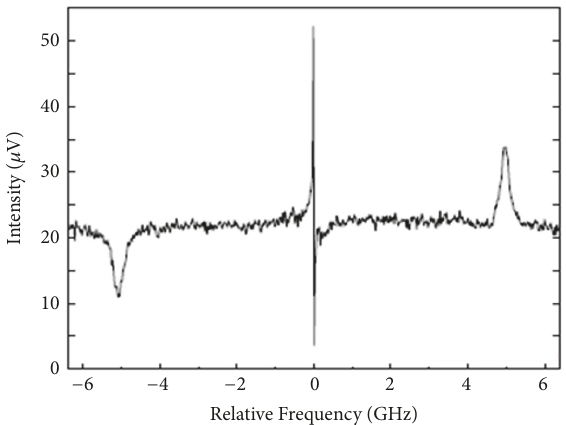
Figure 7: SBS spectrum of water, showing intensity of probe versus frequency of pump [adapted from